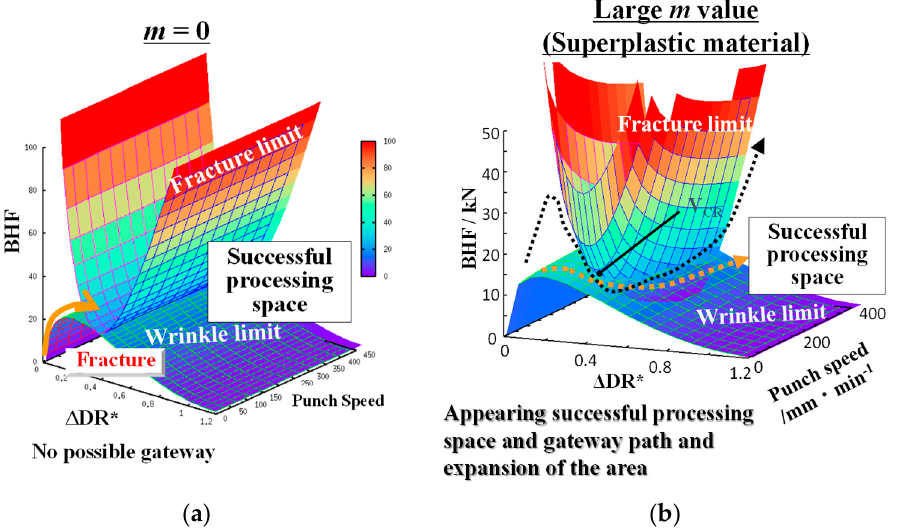
Figure 12. Conceptual three-dimensional representation of the flange wrinkle limit and fracture limit in warm deep drawing process of strain rate dependent material. ( a ) No strain rate-dependent material. No gateway to successful processing space. ( b ) High strain rate-dependent material (superplastic material, appearance of gateway region to successful processing space).